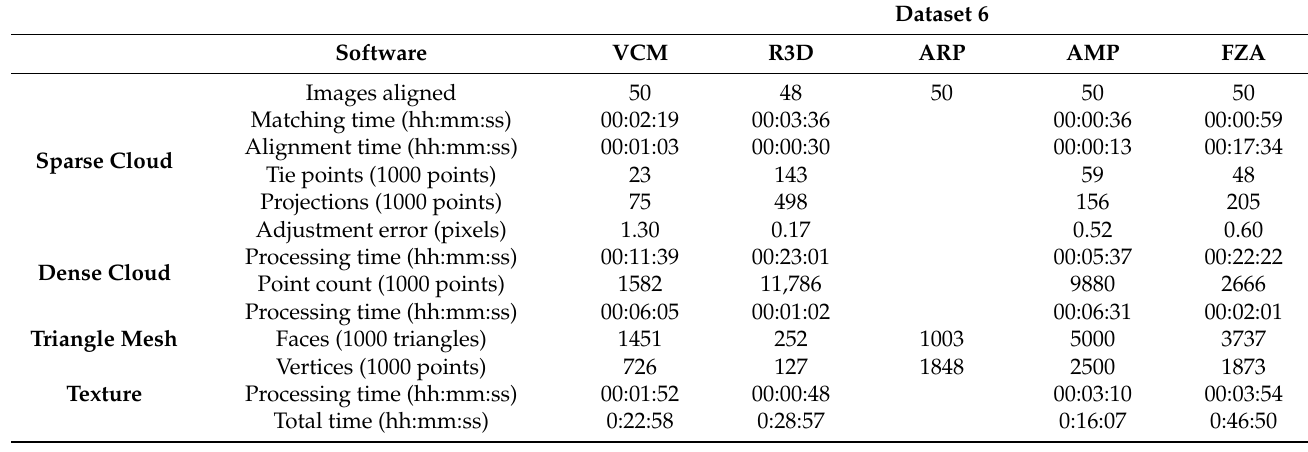
Table 7. Photogrammetric results, datasets 7–9.